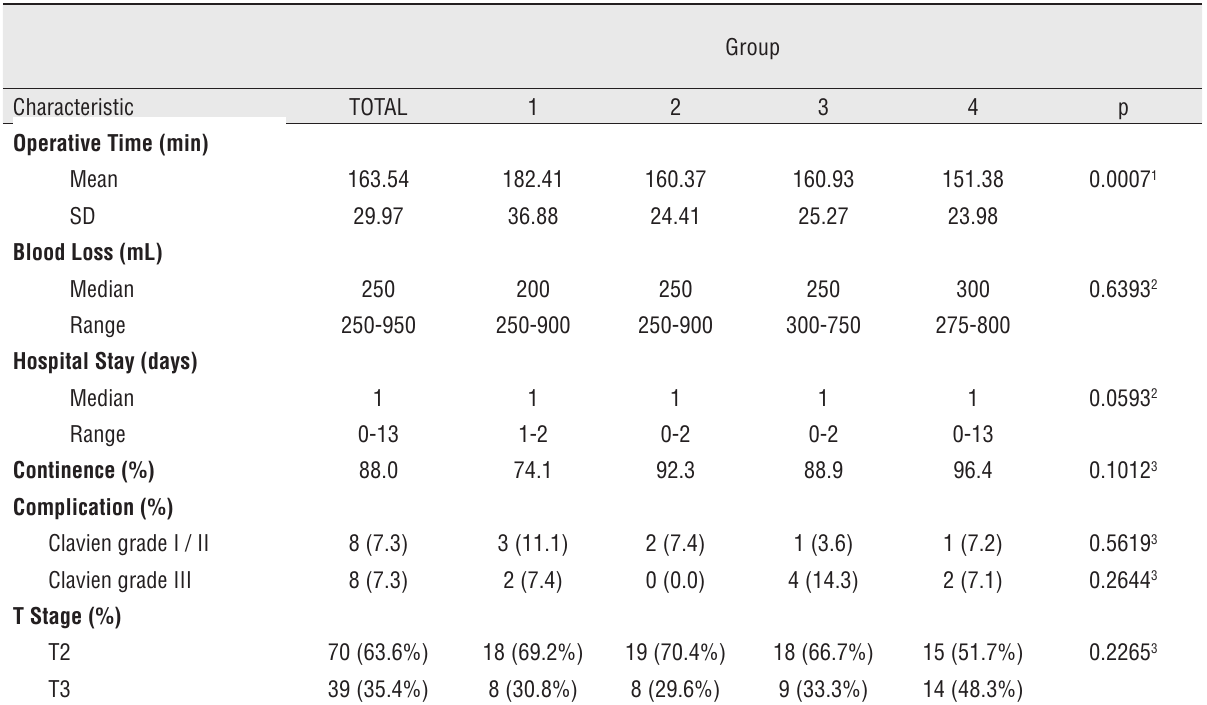
Table 2 - Perioperative Data.